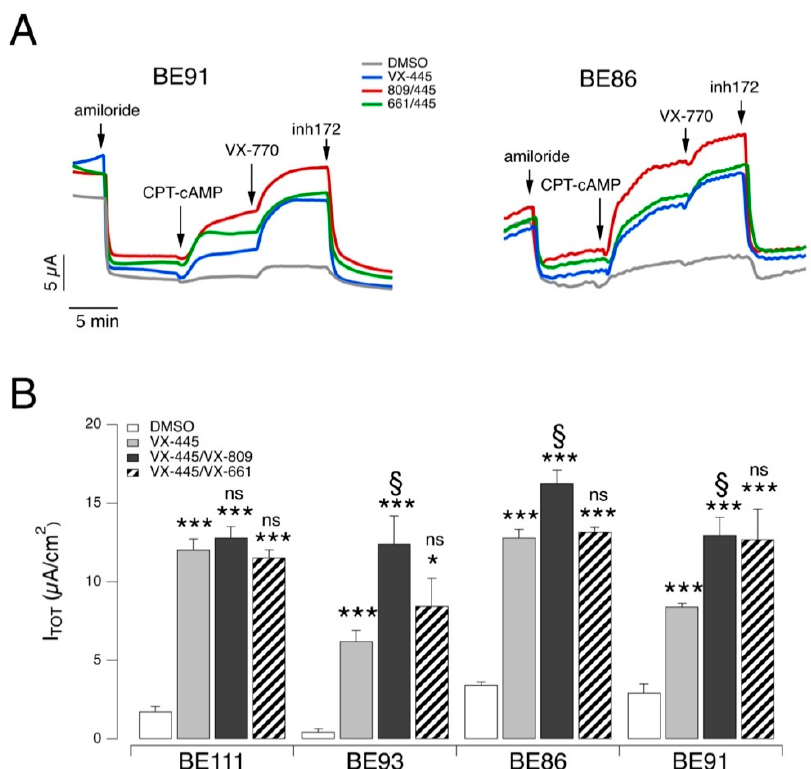
Figure 3. Functional evaluation of VX-445-based combinations on F508del/F508del human bronchial epithelial cells. ( A ) Representative traces of the effect of vehicle alone (DMSO) or VX-445 (3 µ M), VX-809 (3 µ M), or VX-661 (10 µ M) as single agents or combinations in F508del/F508del bronchial epithelial cells (BE91 and BE86) with the short-circuit current technique. ( B ) Summary of results obtained from short-circuit current recordings on F508del/F508del bronchial epithelial cells derived from four different CF patients. Data reported are the amplitude of the current blocked by 10 µ M inh-172 (I TOT ; mean ± SD, n = 5). Asterisks indicate the statistical significance of single correctors vs. control (DMSO-treated): *, p < 0.05; ***, p < 0.001. Other symbols indicate the statistical significance of combinations of correctors vs. VX-445 alone: §, p < 0.05; ns, not significant.